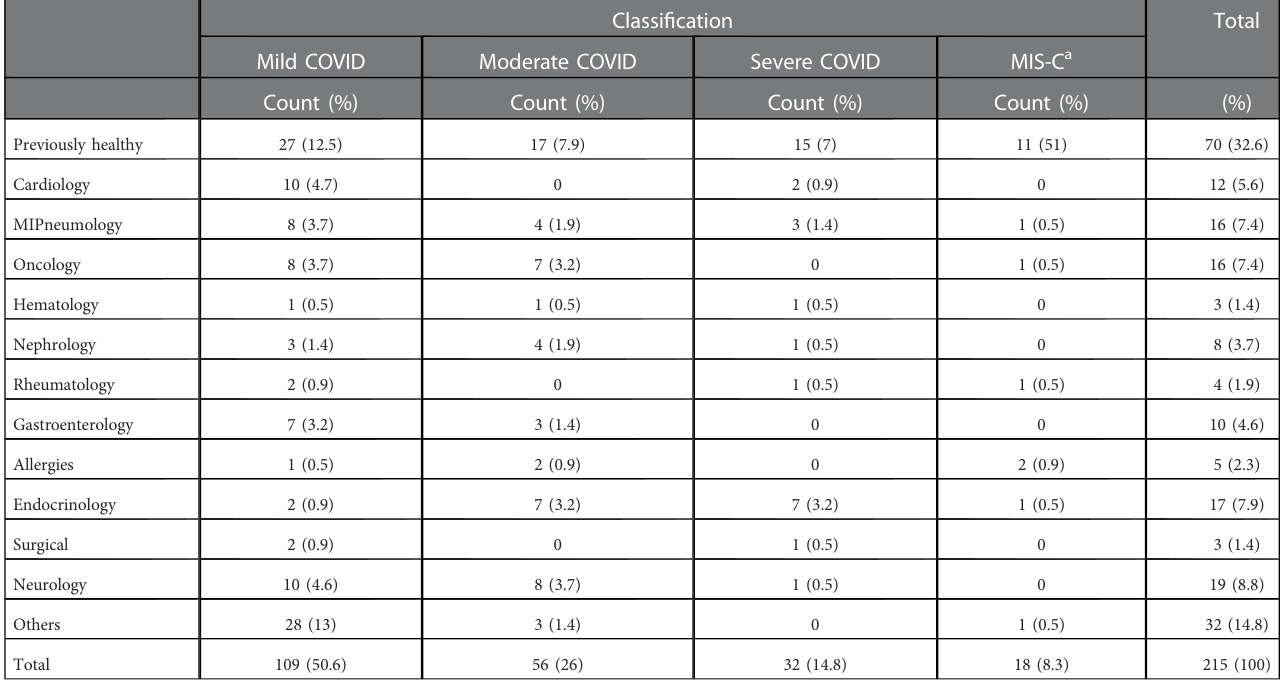
TABLE 1 Etiological groups associated with COVID-19